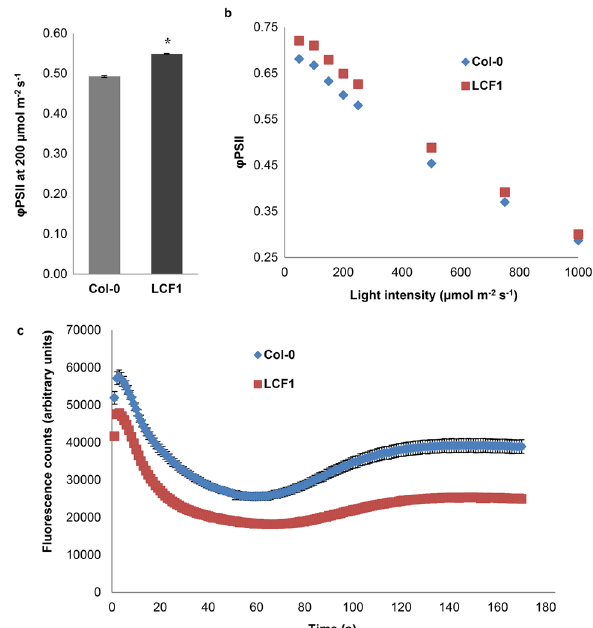
Figure 3. Quantification of the operating efficiency of Photosystem II ( ϕ PSII) of Col-0 and LCF1